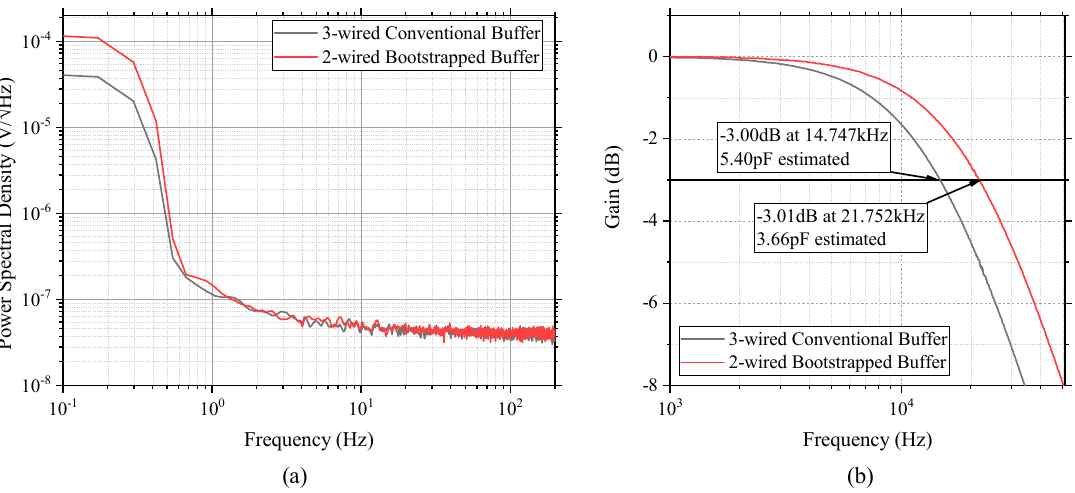
Figure 4. ( a ) Measurements of the noise power spectral densities and ( b ) input capacitance estimation results for the proposed active electrode circuit and its alternative implementation (2-wired bootstrapped buffered topology vs. 3-wired conventional buffered topology).